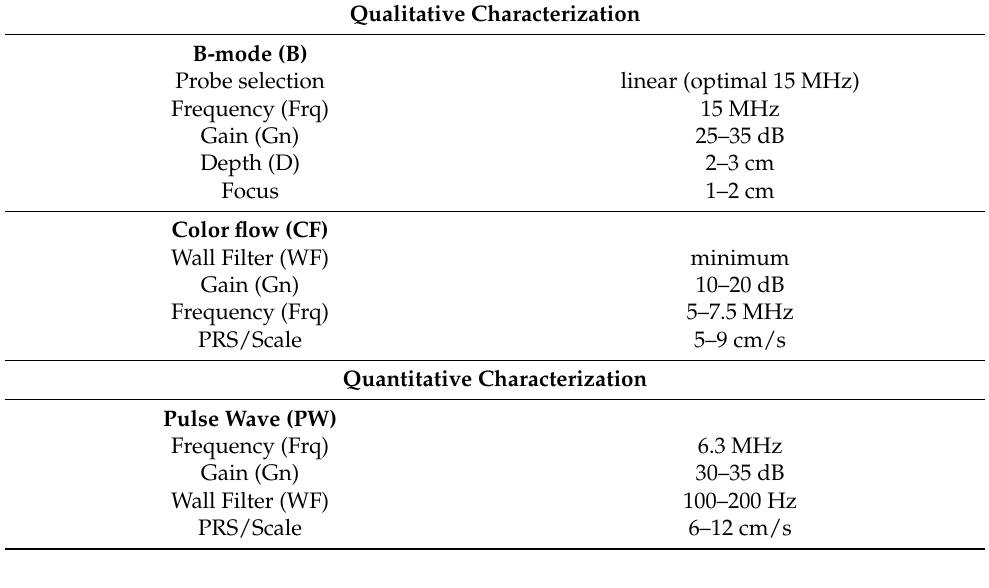
Table 1. Recommended presets for perforator evaluation of the SCIP flap.